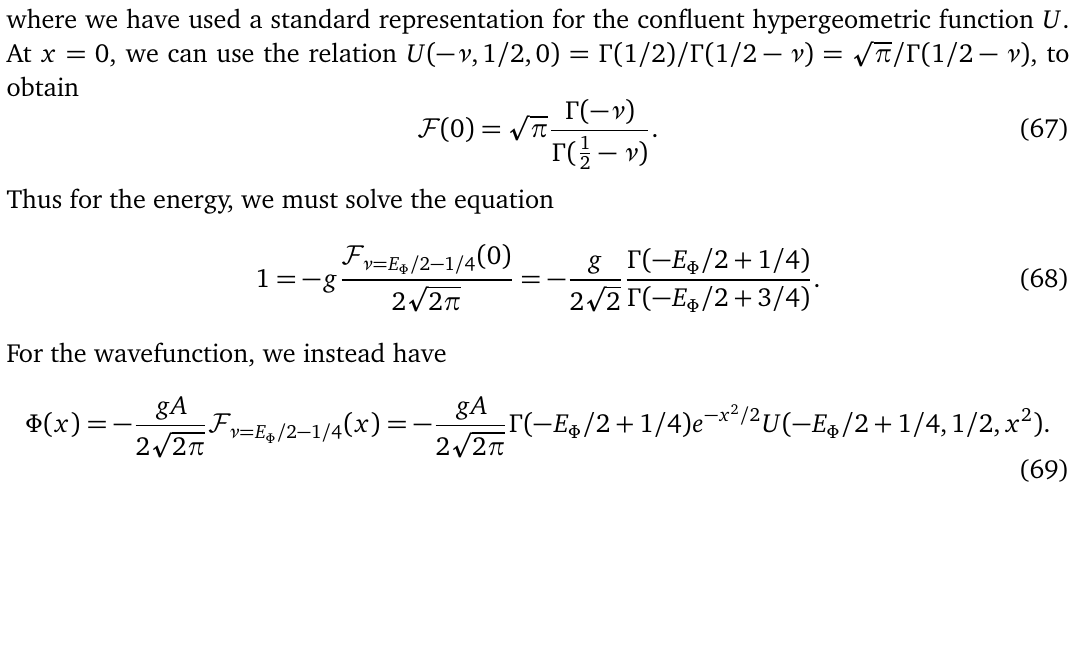
= 1 in the harmonic